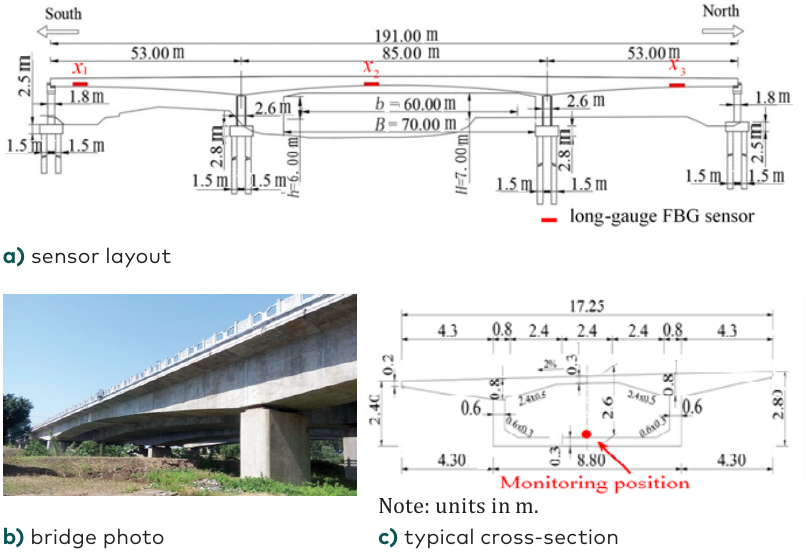
c) typical cross-section b) bridge photo Note: units in m.